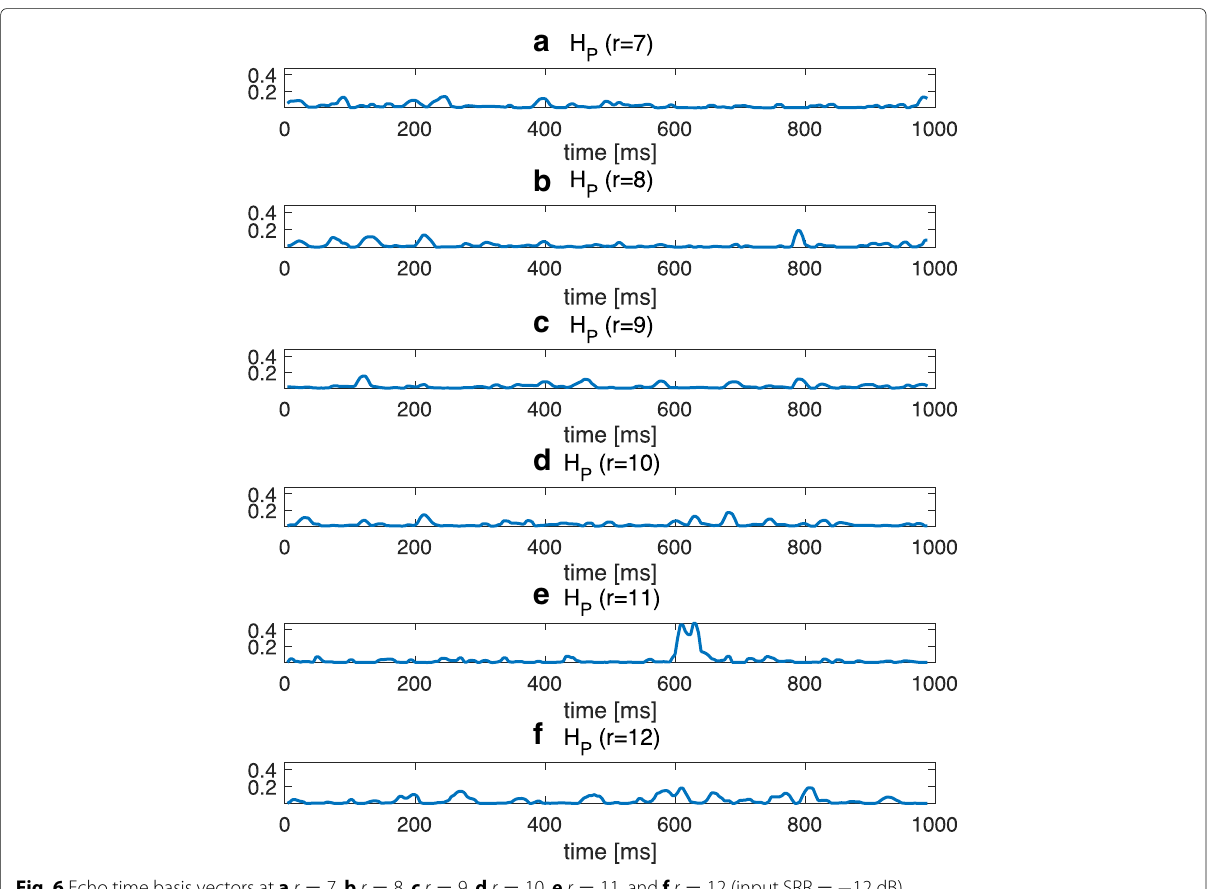
Fig. 6 Echo time basis vectors at a r = 7, b r = 8, c r = 9, d r = 10, e r = 11, and f r = 12 (input SRR = − 12 dB) ideal target echo and reverberation (Fig. 7b), the output signal obtained using the proposed algorithm (Fig. 7c), the SSE algorithm (Fig. 7d), the AR pre-whitening algo- rithm (Fig. 7e), and the PCI algorithm (Fig. 7f). For the algorithms, we consider the input signal shown in Fig. 7b.